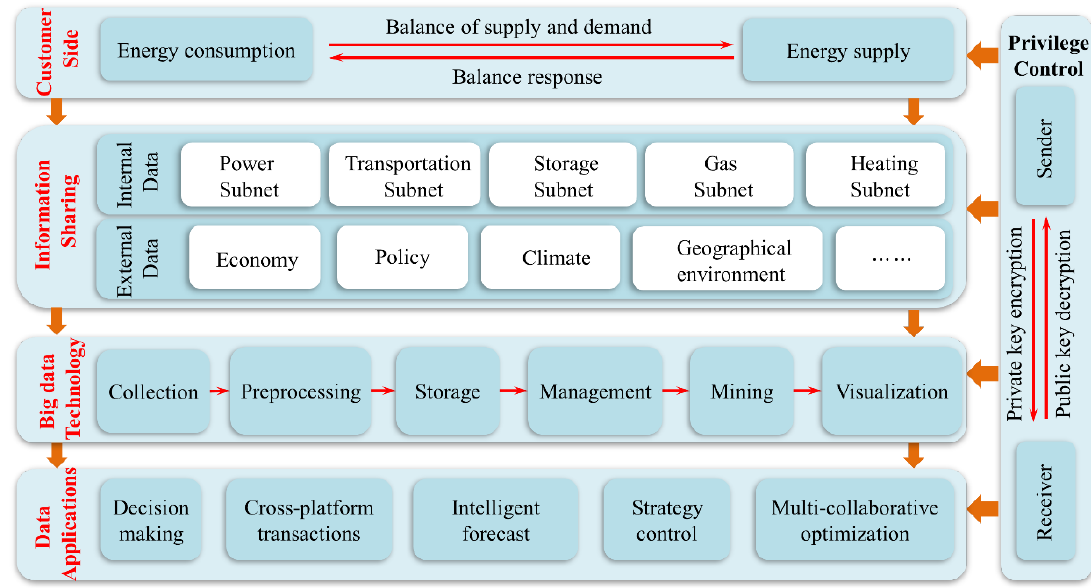
Figure 8. Achieving multioptimization configuration through information sharing based on the blockchain.